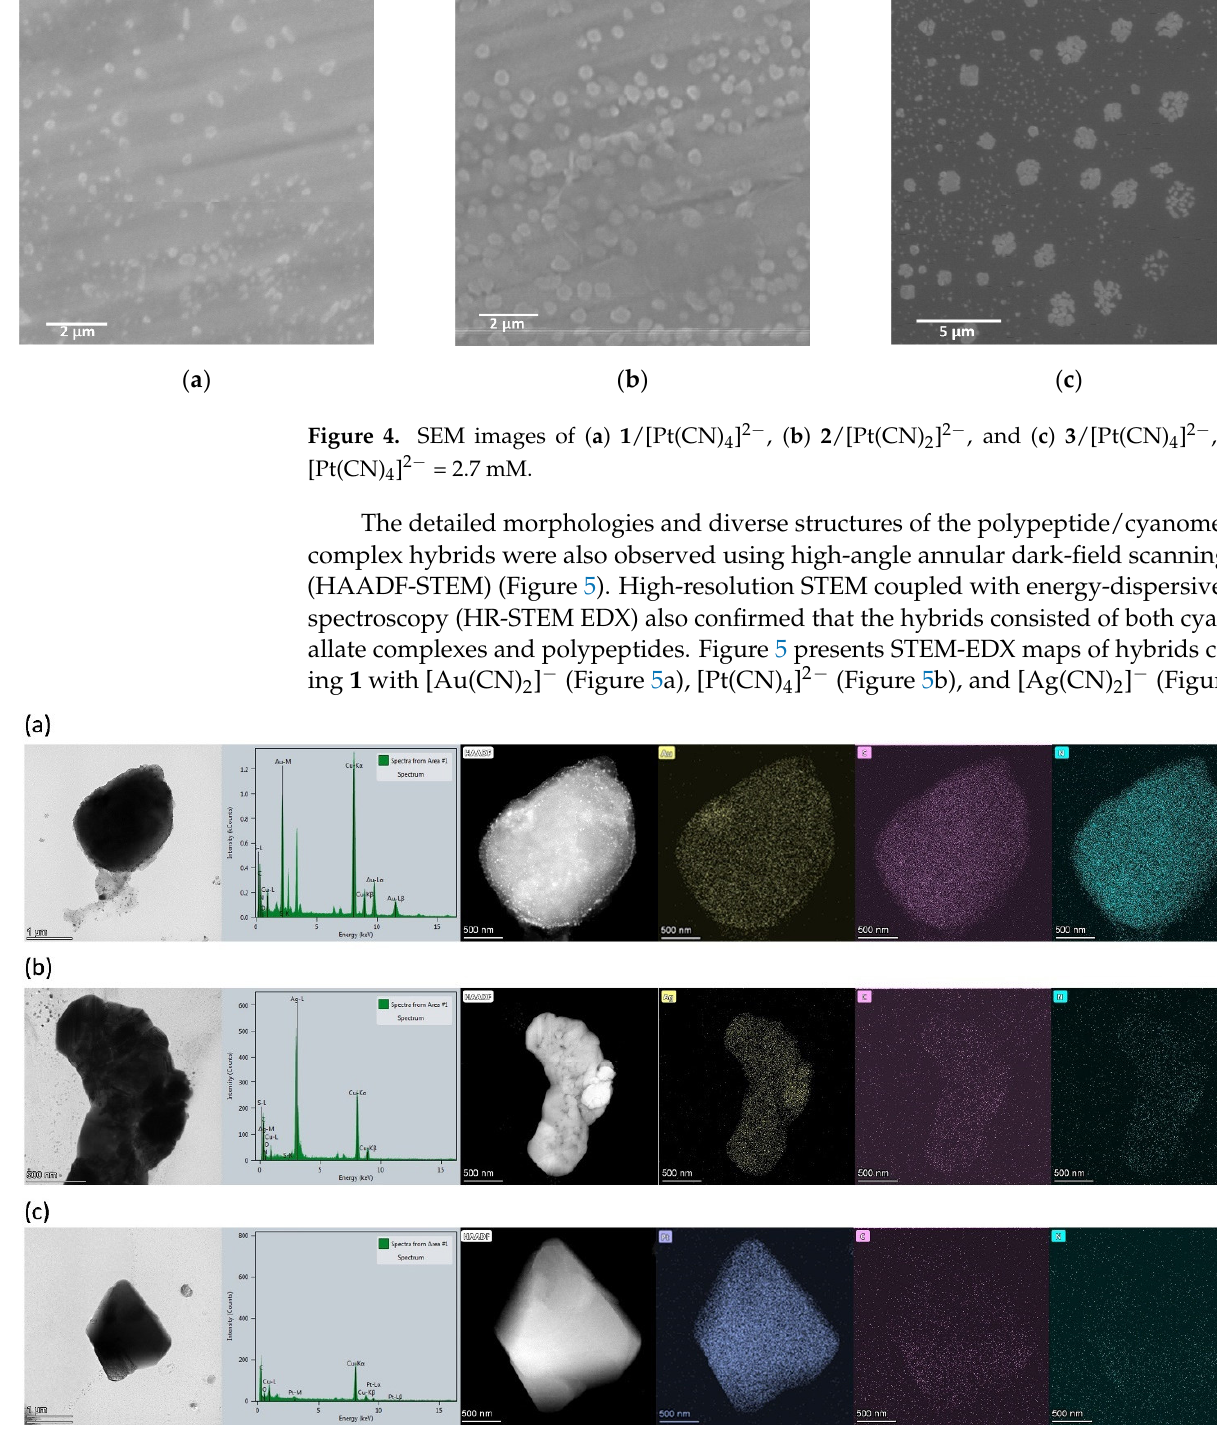
Figure 5. HAADF-STEM images and STEM-EDX maps (showing metals (Au, Ag, Pt), C, and N) for hybrids of ( a ) [Au(CN) 2 ] − , ( b ) [Ag(CN) 2 ] − , and ( c ) [Pt(CN) 4 ] 2− with diblock copolypeptide amphiphile 1 , where [Au(CN) 2 ] − = 3.5 mM, [Ag(CN) 2 ] − = 5.0 mM, and [Pt(CN) 4 ] 2− = 2.7 mM. The size distributions of the nanostructures in water were also analyzed using dynamic light scattering at 25 ◦ C (Figure 6 and Table 2) The data show multidisperse scattering with at least one or two peaks for each sample in the volume-based size distributions over the range of 50 to 1000 nm, in agreement with the SEM and TEM images (Figures